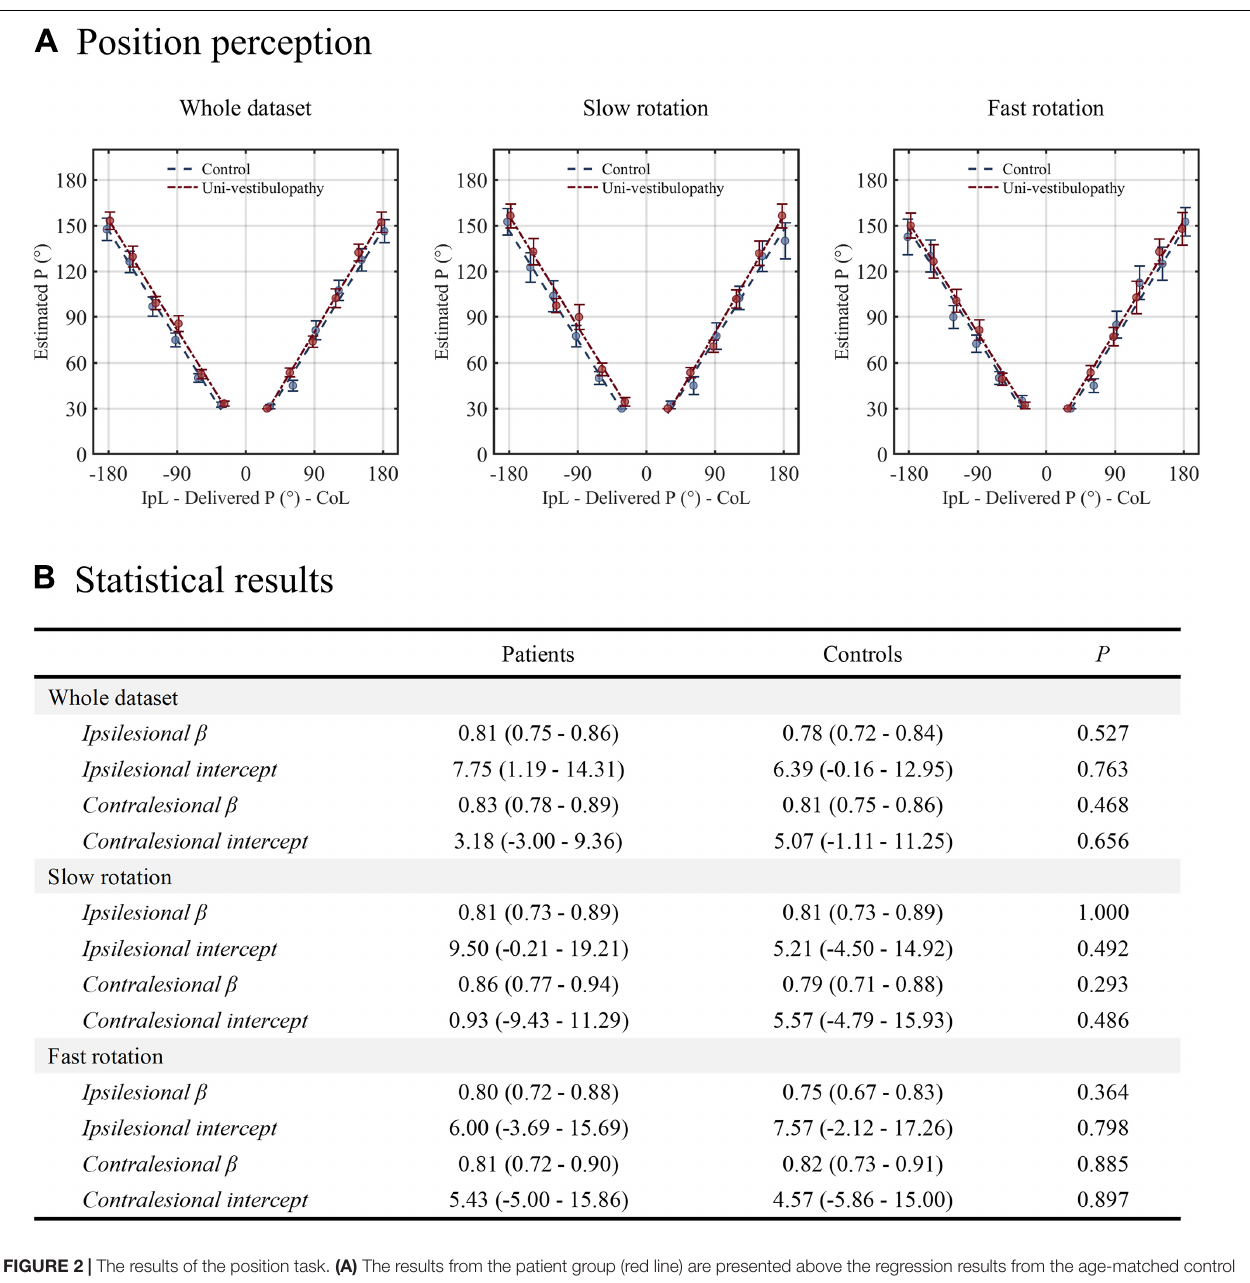
FIGURE 2 | The results of the position task. (A) The results from the patient group (red line) are presented above the regression results from the age-matched control group (blue line). (B) The results of statistical analyses performed for the position task. Statistical analyses were performed using the generalized linear model with a linear fit. For clarity, the statistical model presented in this figure did not include velocity covariates. β indicates the change in the position estimate in response to the change in the actual stimulus. The intercept value indicates the static positional bias. IpL, ipsilesional; CoL,